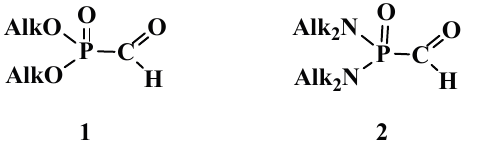
Figure 1. Structures of dialkyl formylphosphonates ( 1 ) and N,N,N',N' -tetraalkyl formylphosphondiamides ( 2